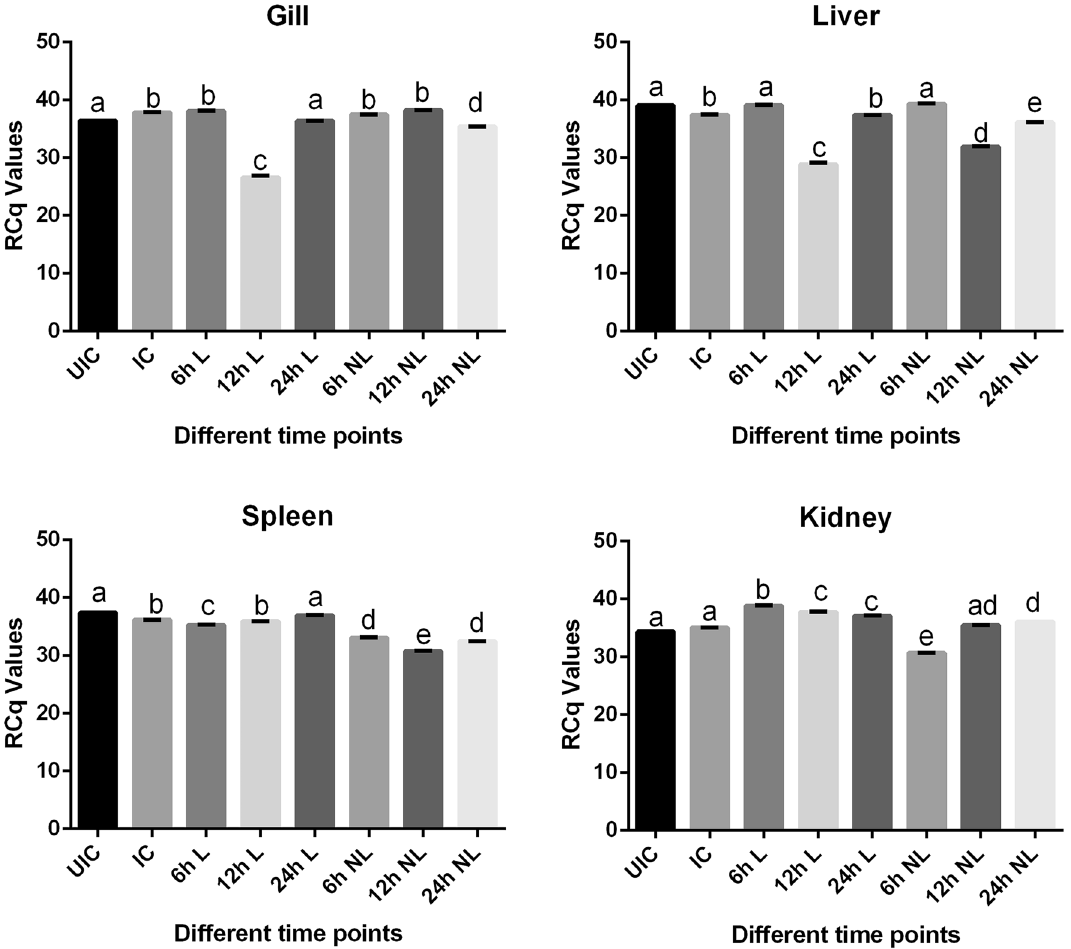
control, IC infected control, L lectin treated, NL lectin-PtNPs hybrid